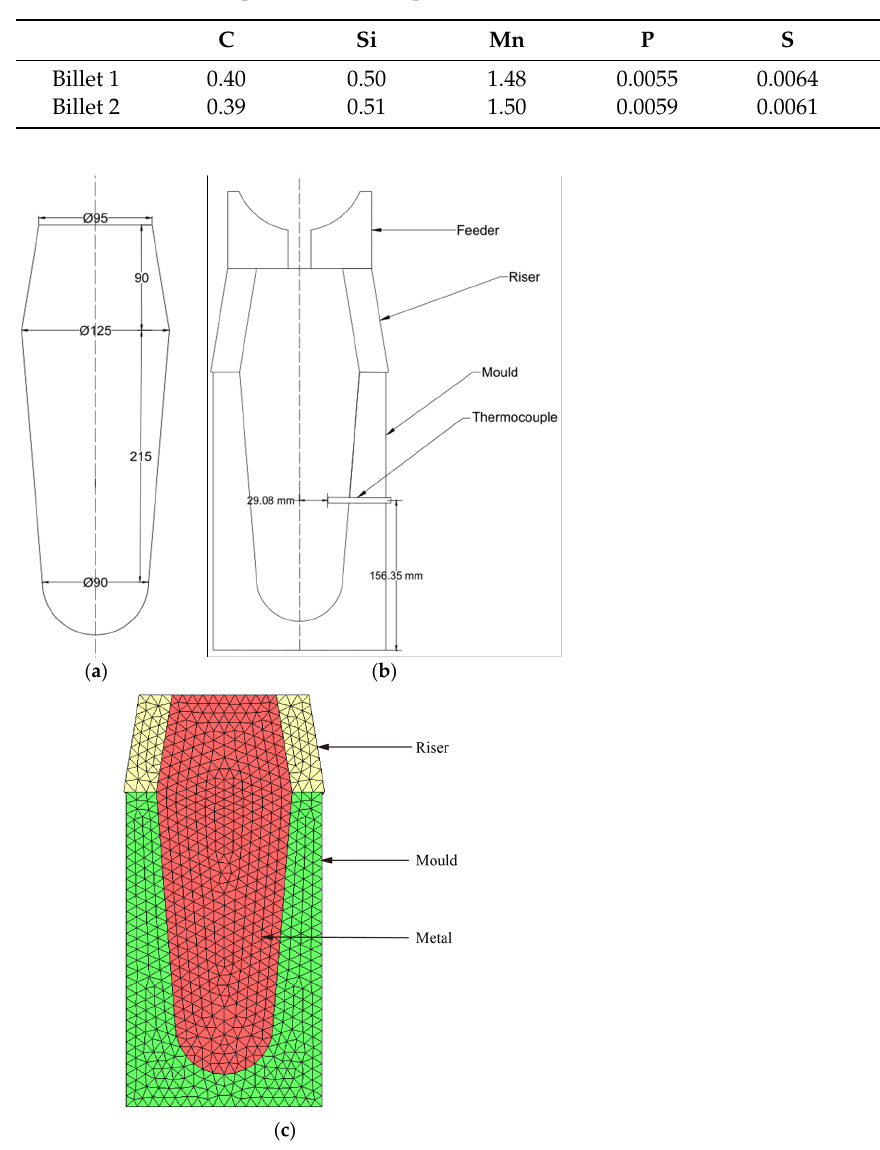
Table 1. Chemical composition of the experimental billets (wt%).